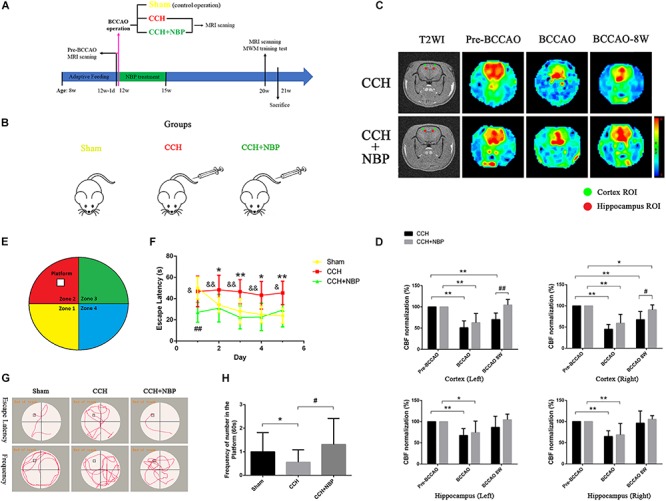
(A) The experimental flowchart in vivo. Eight-week-old adult male SD rats were obtained and kept for 4 weeks of adaptive feeding. The day before 12 weeks of age (12w-1d), MRI scanning was performed, and the CBF was obtained before the operation (pre-BCCAO). At 12 weeks of age, the operation was performed and the CBF was detected using MRI (15 min after operation). Rats were randomly divided into three groups: Sham (control operation), the bilateral carotid arteries were separated as in the BCCAO group, without being ligated; CCH (BCCAO operation), the bilateral carotid arteries were double-ligated; CCH + NBP: BCCAO operation combined with consecutive NBP treatment for 3 weeks. Eight weeks after the BCCAO operation (20 weeks old), behavioral function was evaluated in the MWM test, and CBF was detected using MRI scanning. Rats were sacrificed for further experiments (21 weeks old). (B) Animal groupings used in this study. Rats were randomly divided into three groups: Sham, without ligated; CCH, 8 weeks after double-ligated operation, injection with solvent; CCH + NBP: NBP injection for early 3 weeks with 8 weeks after BCCAO operation. (C) Changes in CBF in the cortex and hippocampus were showed by MRI images. Color images are from 3D ASL, gray images from T2WI. Red and green circles indicate detected ROIs of CBF in the hippocampus and cortex, respectively. Histogram showing quantitative results in the different groups after BCCAO operation. (D) CBF in the bilateral cortex and hippocampus decreased immediately following BCCAO and 8 weeks after BCCAO, compared to pre-occlusion CBF (P < 0.01). CBF increased in the NBP treatment group compared to the BCCAO group. (*P < 0.05, ∗∗P < 0.01, compared to the pre-BCCAO; #P < 0.05, ##P < 0.01, the NBP treatment compared to the CCH). (E) Diagram of the MWM. The four colors divide the round swimming pool (the large circle) into four quadrants (Yellow, 1st quadrant; Red, 2nd quadrant; Green, third quadrant; Blue, fourth quadrant). The empty square represents the platform in the 2nd quadrant. (F) Escape latency changes in the different groups from day 1 to day 5 (*P < 0.05, ∗∗P < 0.01, CCH group vs. sham group; ##P < 0.01, CCH + NBP group vs. sham group; &P < 0.05, &&P < 0.01, CCH vs. CCH + NBP group). (G) Swimming path of rats at day 6. The swimming path distance in the platform quadrant was reduced in the CCH. NBP treatment increased the frequency at the platform. (H) Quantified changes in the frequency at the platform between the three groups (*P < 0.05, CCH group vs. the sham group; #P < 0.05, CCH vs. CCH + NBP group). CCH: CCH 8w; CCH + NBP: CCH 8w + NBP.